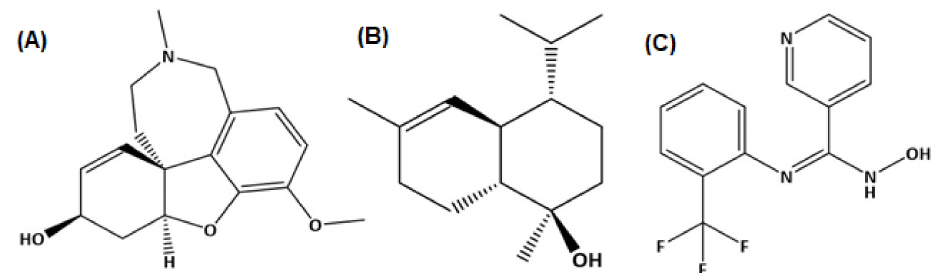
Figure 12. Structures of GC-MS profiled compounds and galanatmine docked with acetyl- cholinesterase and butyrylcholinesterase. ( A ) Galantamine, ( B ) alpha-cadinol, and ( C ) N-hydroxy-N (cid:48) -